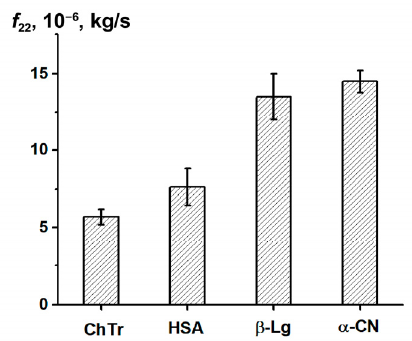
Figure 6. Protein–protein friction coefficient f 22 for diluted protein solutions.